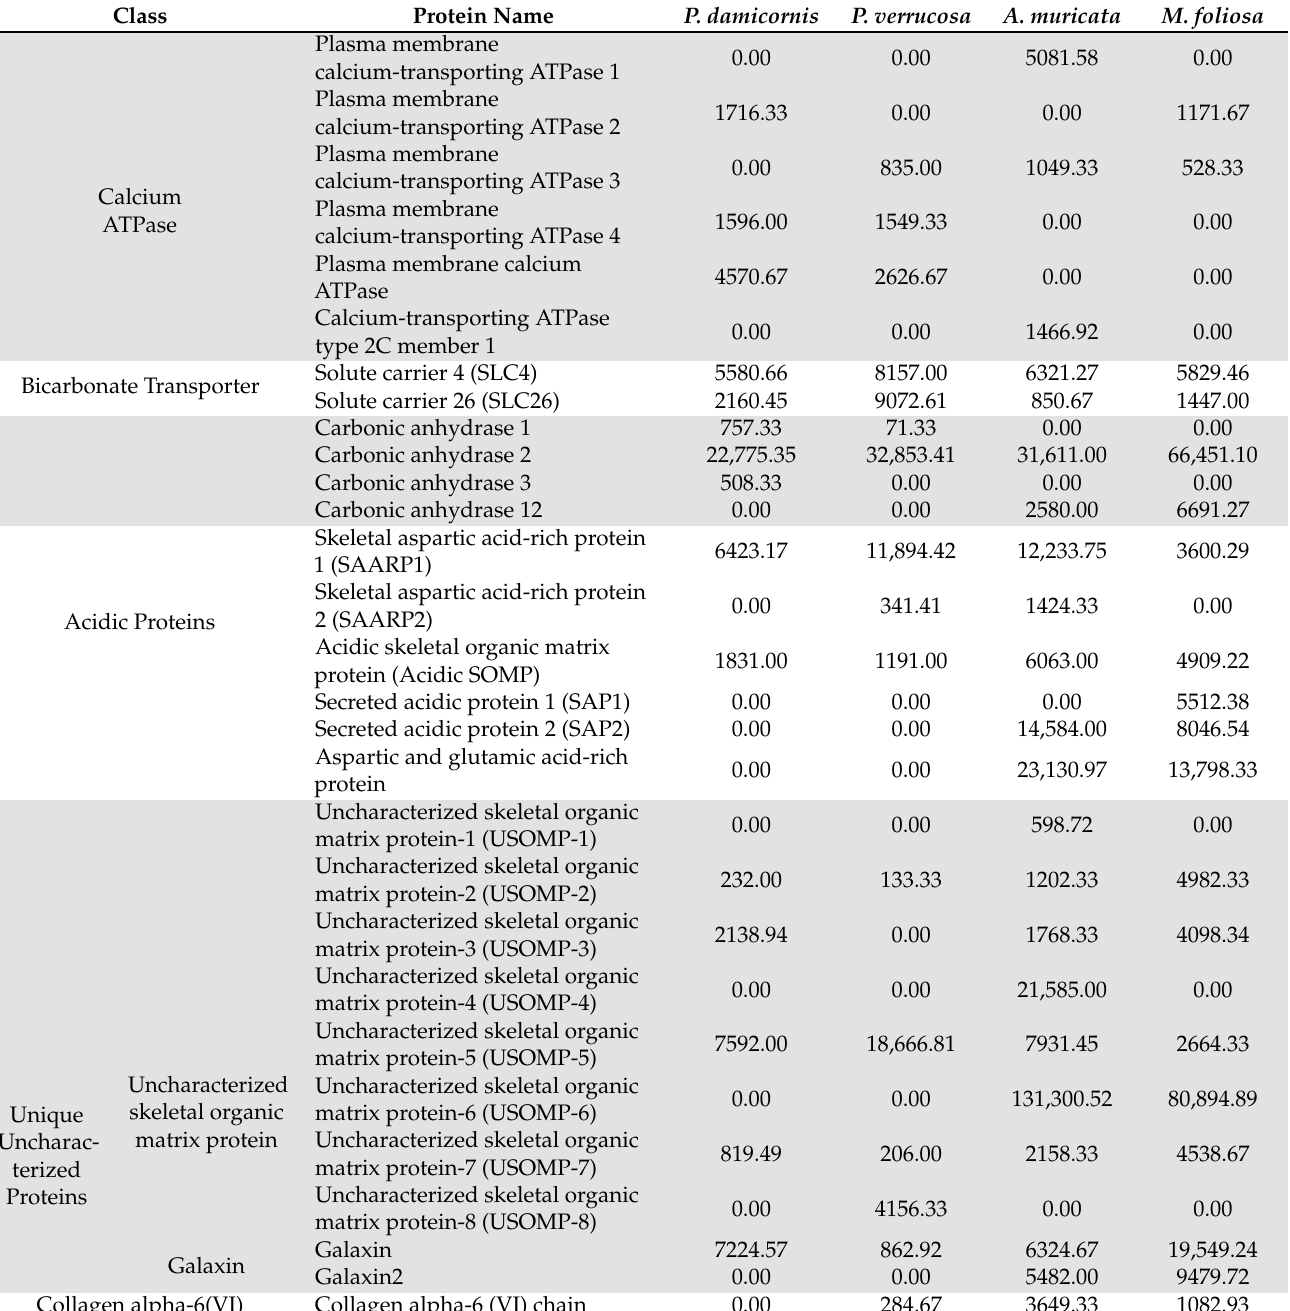
Table 4. Average read-count values of key biomineralization-related genes in four investigated